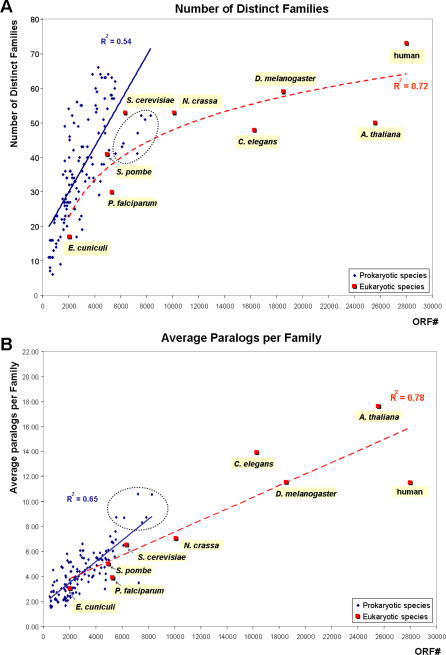
Number of Total ORFs versus Number of Distinct Transporter Families or Average Number of Paralogs per FamilyThe number of total ORFs in the genome for each of the 141 sequenced prokaryotic and eukaryotic organisms (x-axis) was plotted as a function of either the number of distinct transporter families (A) or the average number of paralogs per family (B) (y-axis). Blue diamonds represent prokaryotic organisms and red squares represent eukaryotic organisms. Trend line and power correlation R
2 value are shown for prokaryotes and eukaryotes, respectively. A group of α-Proteobacteria are enclosed by a circle (see text for discussion).